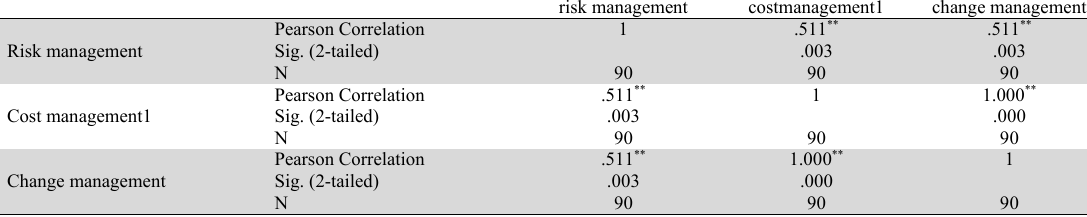
Correlations among Risk, cost and Change